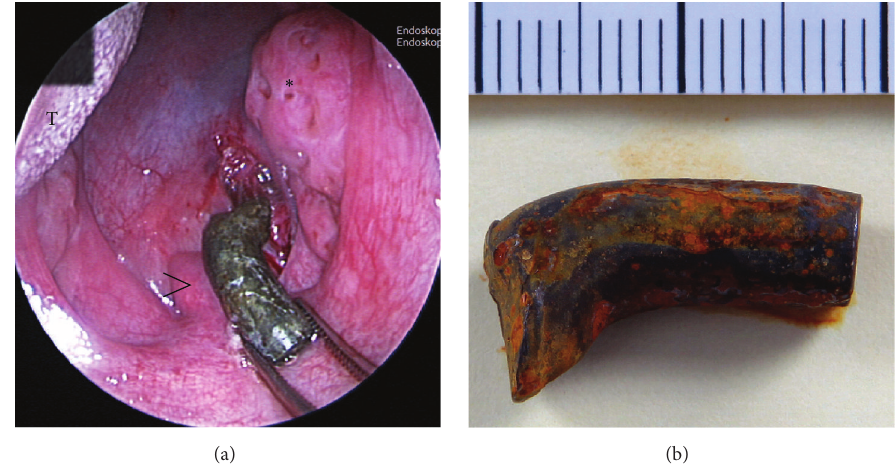
Figure 3: Intraoperative picture showing the extraction of the bullet (a); asterisk: right tonsilla palatina, arrowhead: uvula, and T: tongue. The tip and the jacket of the extracted bullet were torn off (b). The steel core was deformed and the middle portion was bent approximately 45 ∘